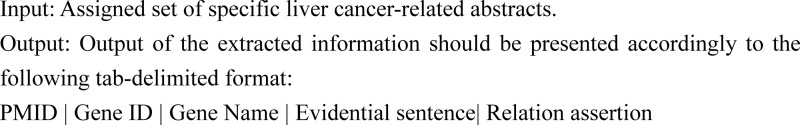
The details of the curation task protocol in BioCreative IV IAT.